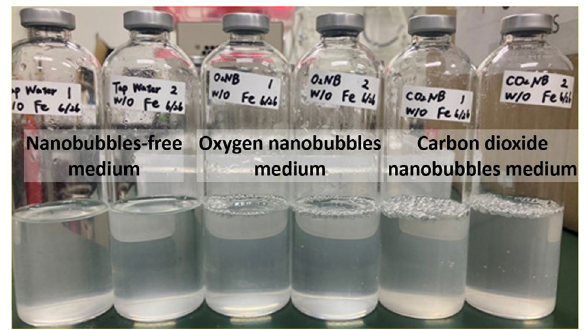
Figure 8. Photo image of the culture solution of P . aeruginosa cultured in the Cooper’s medium without addition of ferrous sulfate for 3 days. After 3 days cultivation, the foam generation by P . aeruginosa was